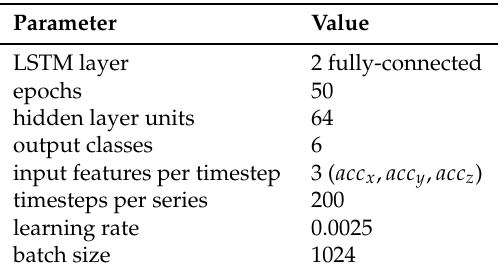
Table 2. Some core parameter definitions for the training.